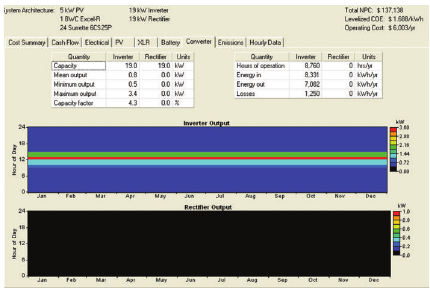
Figure 15: Converter output summary.